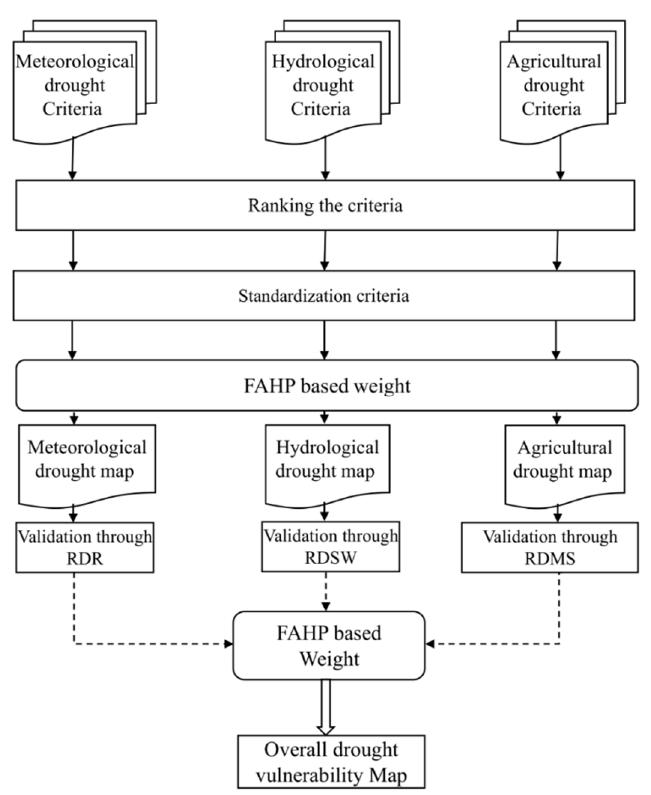
Figure 2. Methodological flowchart applied for assessing drought vulnerability in the present study.